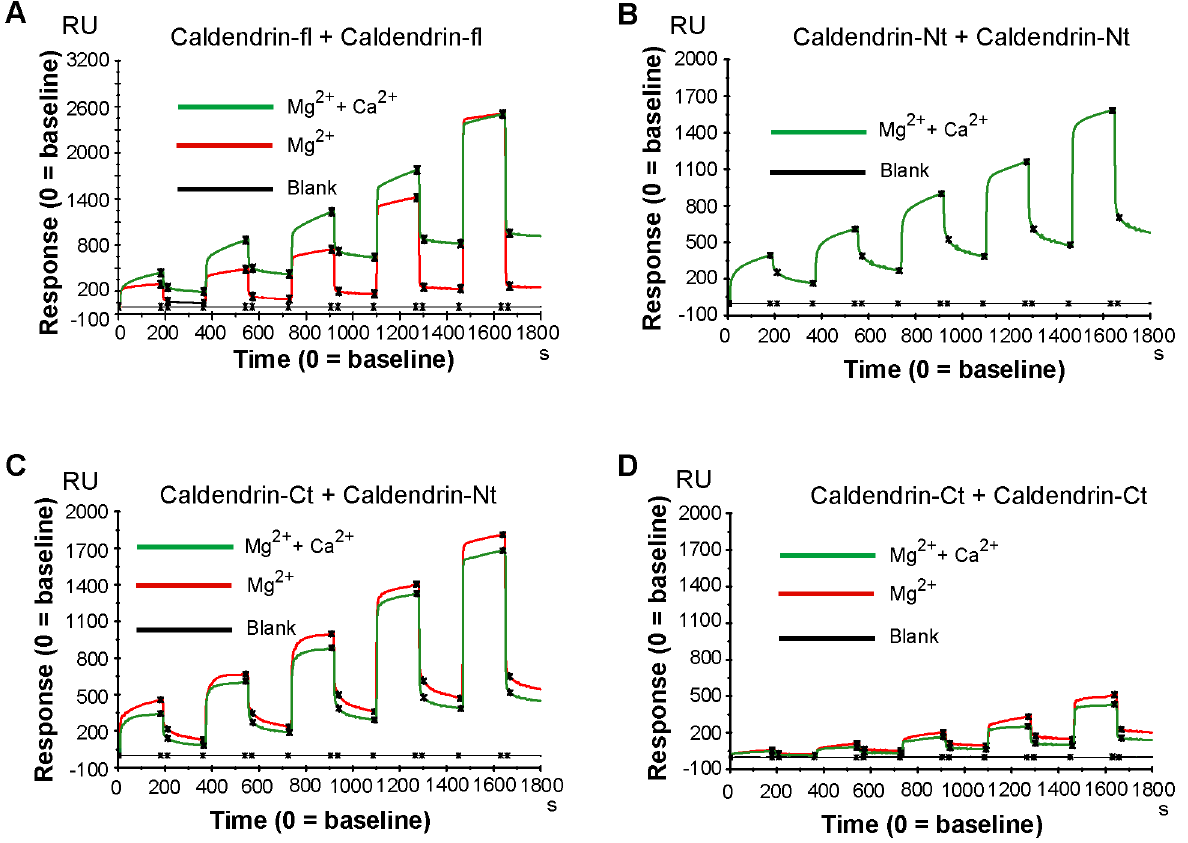
Figure 6. Surface plasmon resonance analysis. (A) Untagged full length Caldendrin was immobilized on a CM5 surface and the full-length Caldendrin was also injected as analyte. (B) The N-terminus of Caldendrin was immobilized on a CM5 surface and also injected as analyte in running buffer. (C) The common C-terminus (CDD-Ct) was immobilized on the sensor chip and the N-terminus injected as analyte. (D) The common C- terminus (CDD-Ct) was immobilized on the sensor chip and also injected as the analyte. (A–D) The running buffer always contained 50 mM Tris-Cl and 100 mM KCl with 1 mM Mg 2 + /1 mM EGTA (red) or 1 mM Mg 2 + /500 m M Ca 2 + (green). Amount of protein in the running buffer was 5, 10, 20, 40, and 80 m g (increasing protein levels correspond to increasing amplitudes). RU: response